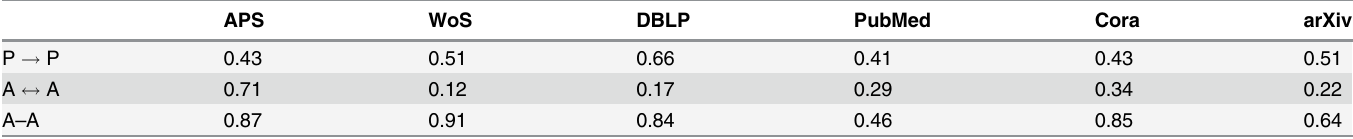
Table 2. Values of clustering mixing. Values of the network measure clustering mixing r b for all 18 examined networks. See text for